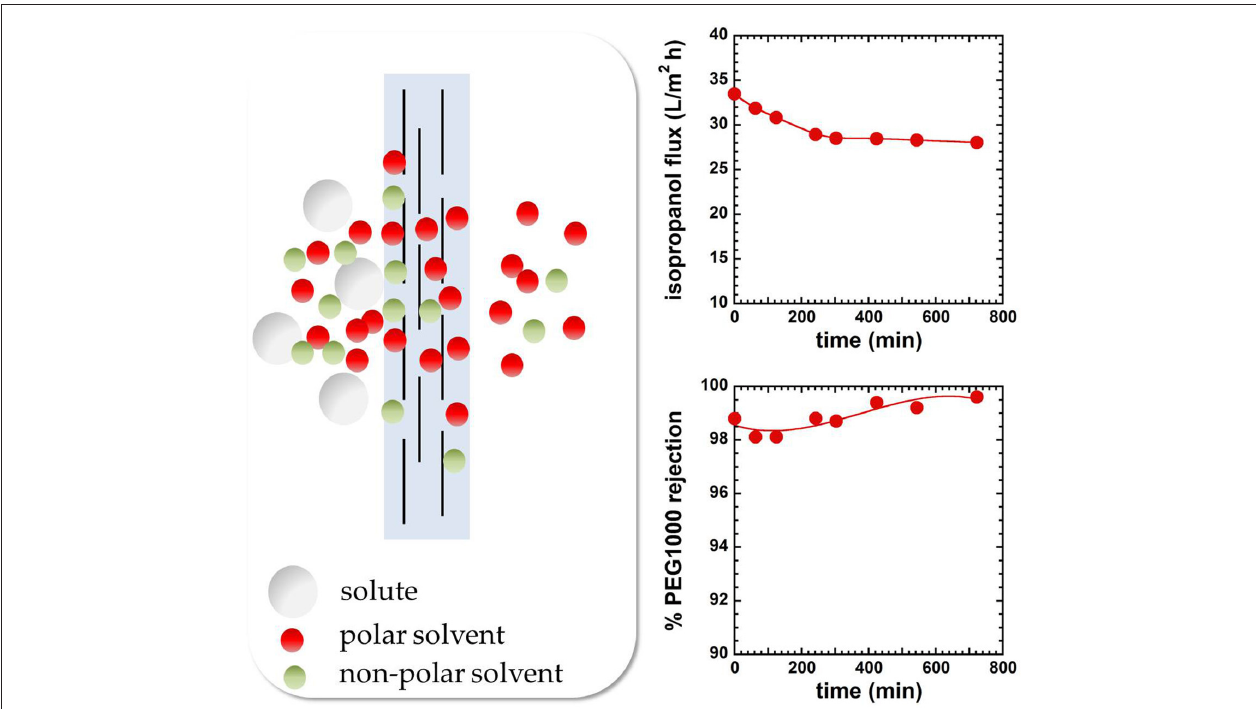
FIGURE 10 | Structure and properties of mixed matrix membranes based on PEIm and MXenes (Wu et al., 2016). OSN experiments were run at room temperature and 10 bar using an isopropanol/PEG1000 solution. Adapted from Wu et al. (2016), with permission of Elsevier .